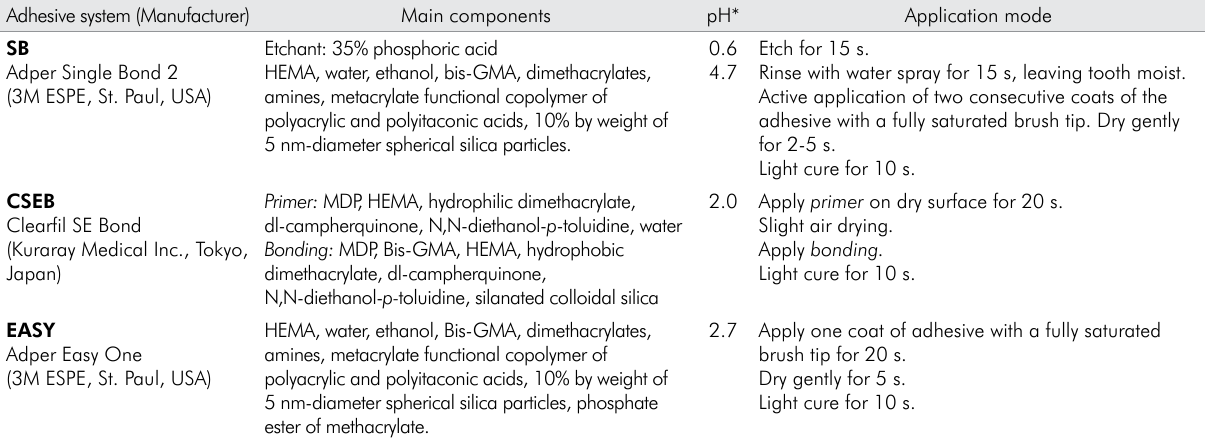
Table 1. Materials, manufacturers, main components, pH, and application mode. Adhesive system